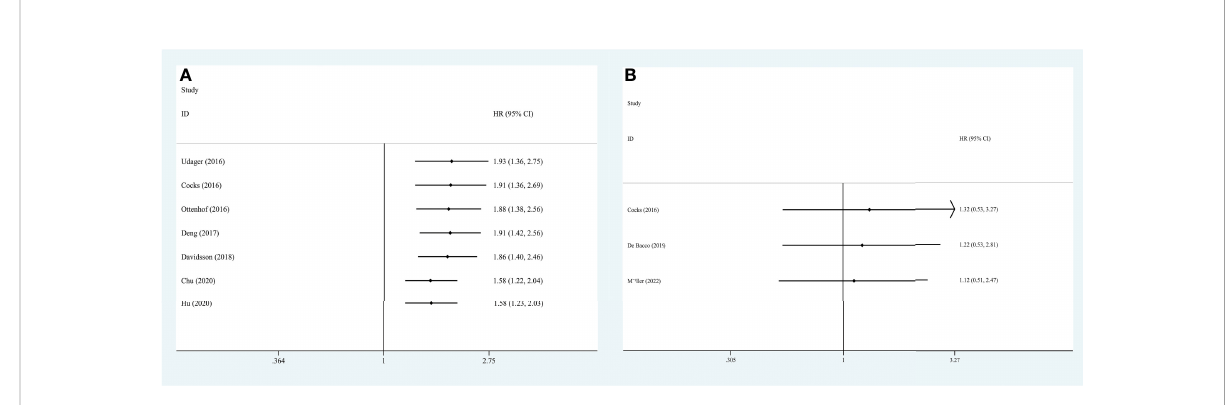
FIGURE 7 Cumulative meta-analysis for OS (A) and CSS (B) , based on year of publication. OS, overall survival; CSS, cancer speci fi c survival; HR, hazard ratio; CI, con fi dence